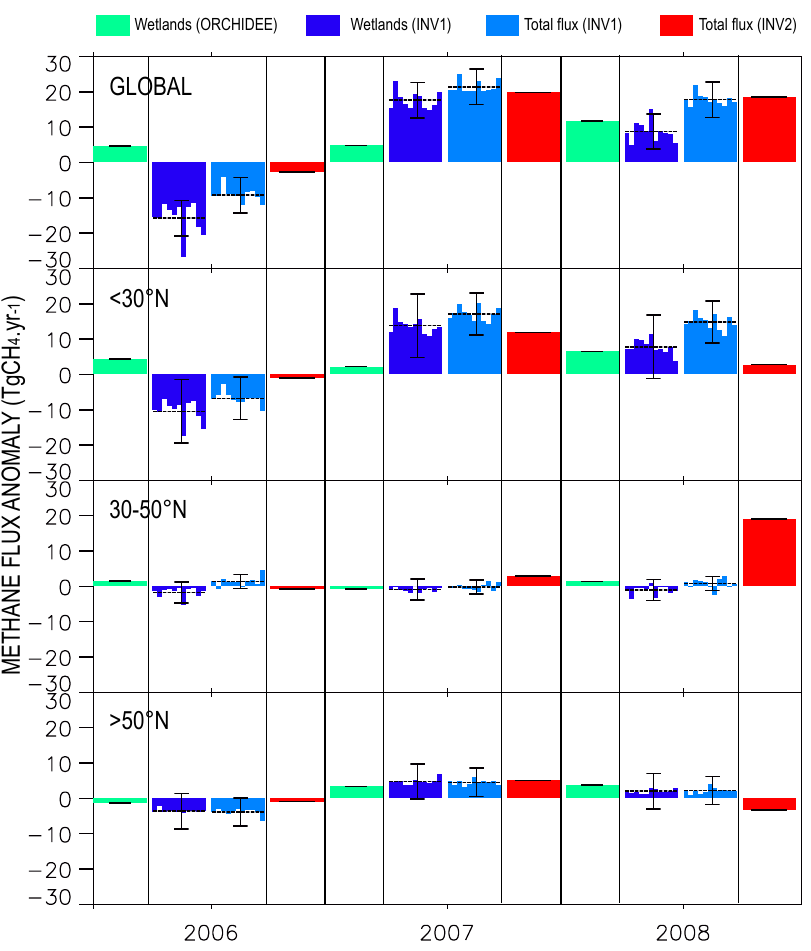
Fig. 1. Anomalies of annual methane emissions in TgCH 4 yr − 1 for 2006 to 2008. The reference period for the anomaly calculation is 1999– 2006. From left to right, each year: wetland anomalies from ORCHIDEE model (green), wetland anomalies from INV1 (11 inversions, dark blue), total anomalies from INV2 (11 inversions, light blue), and total anomalies from INV2 (red). The dark line for each model represents the mean of the performed simulations. From top to bottom: global, < 30 ◦ N, 30–50 ◦ N, > 50 ◦ N. Error bars represent the residual uncertainty returned by the inversion INV1